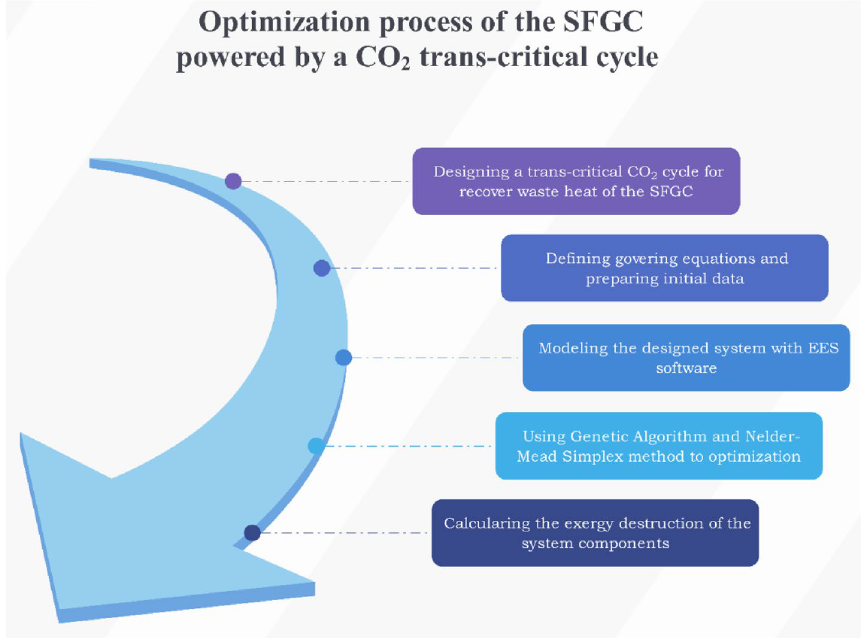
Fig. 1 List diagram of the problem-solving